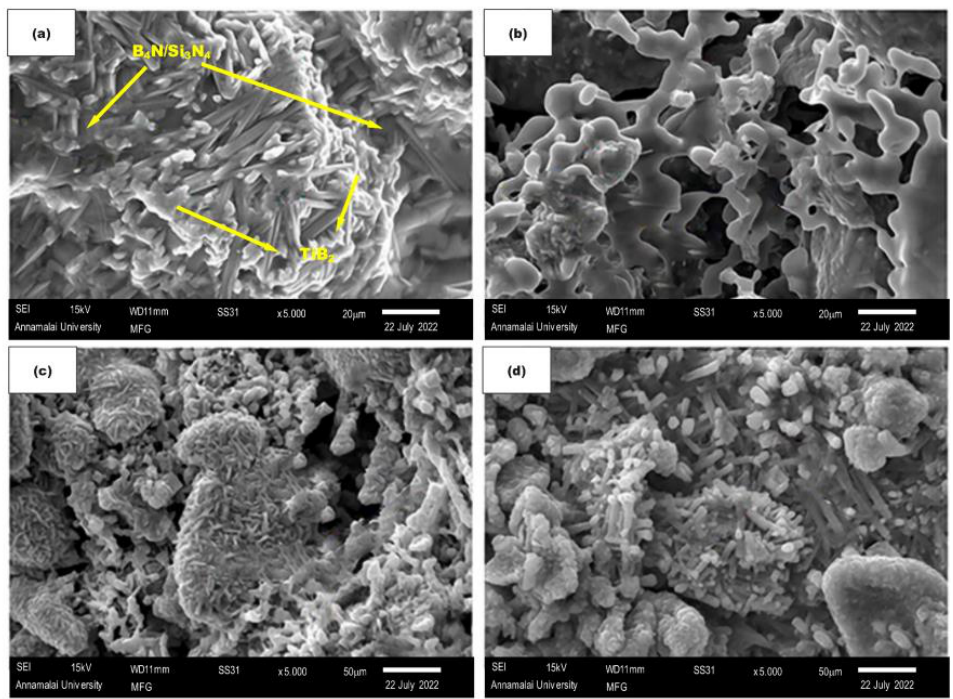
Figure 6. SEM images of the mixed powders: ( a ) TiB 2 -15Si 3 N 4 -3B 4 N, ( b ) TiB 2 -15Si 3 N 4 -6B 4 N, ( c ) TiB 2 -30Si 3 N 4 -3B 4 N, and ( d ) TiB 2 -30Si 3 N 4 -6B 4 N.